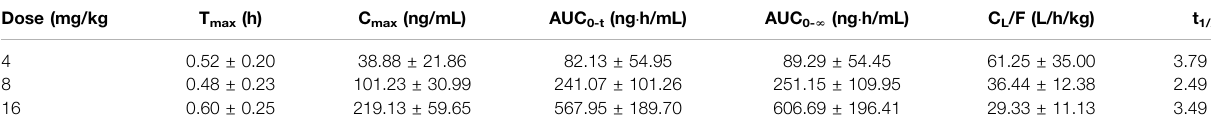
TABLE 6 | Pharmacokinetic parameters of ODV after single administration of toludesvenlafaxine in rats.